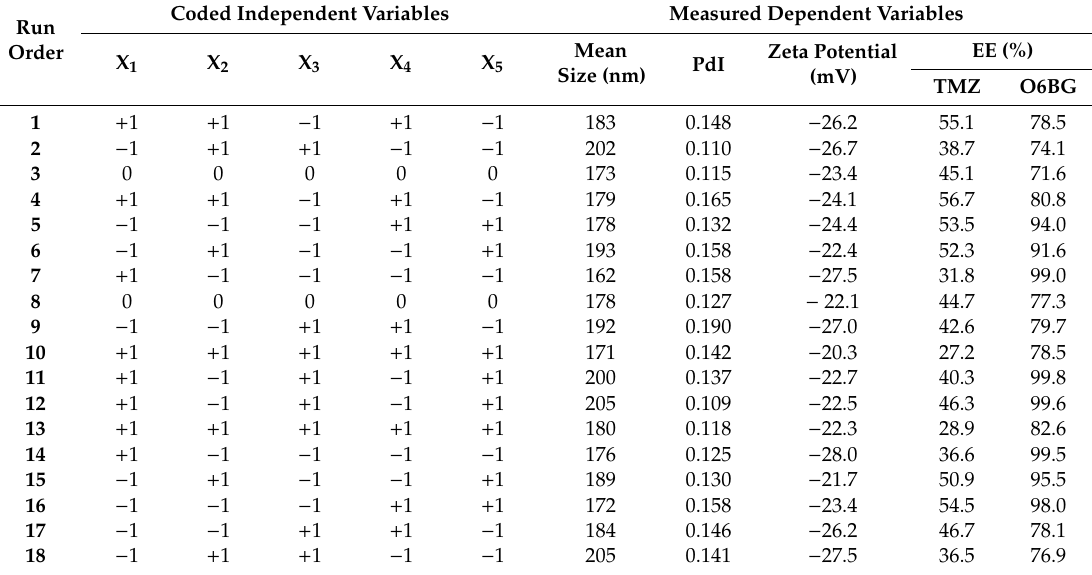
Table 2. Outline of the experimental design and results. The experimental levels (low, centre, and high) are represented by the coded values of − 1, 0, and + 1,